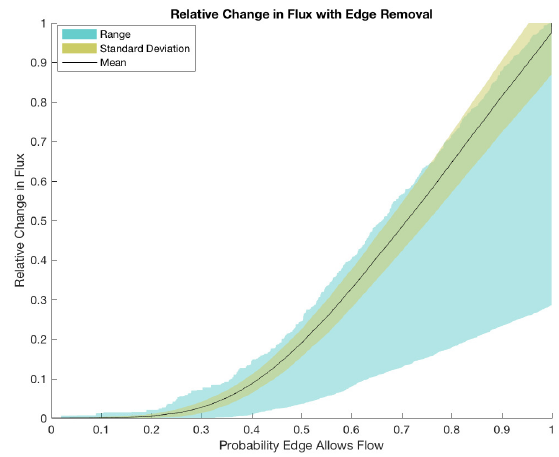
Figure 14. The change in flux as p → p c